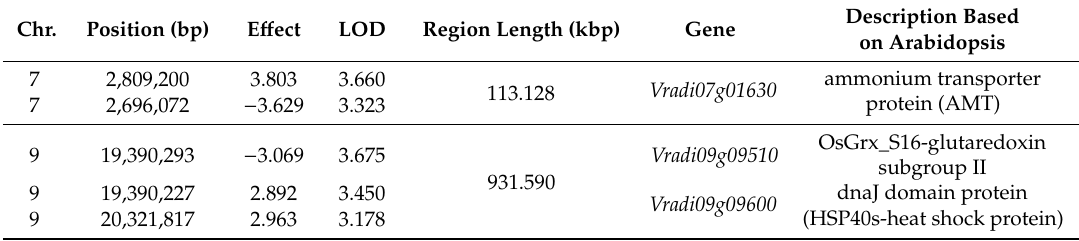
Table 4. SNP logarithm of the odds (LOD) scores, associated regions and gene homologs based according to the annotation given by Kang et al. (2014)